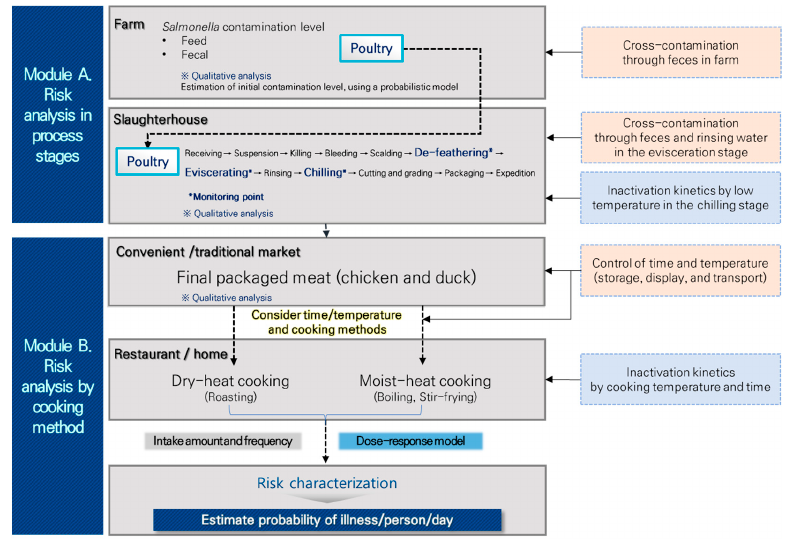
Figure 1. From farm to table, a flowchart illustrating the risk assessment model for Salmonella spp. in chicken and duck.